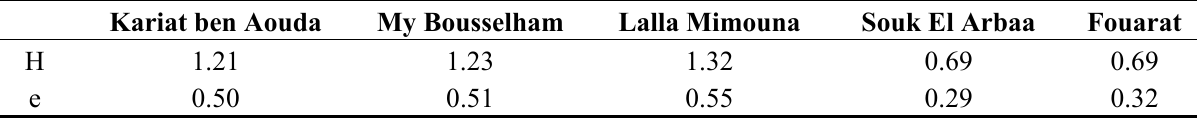
Table 1. Values of Shannon Index (H) and equitability index